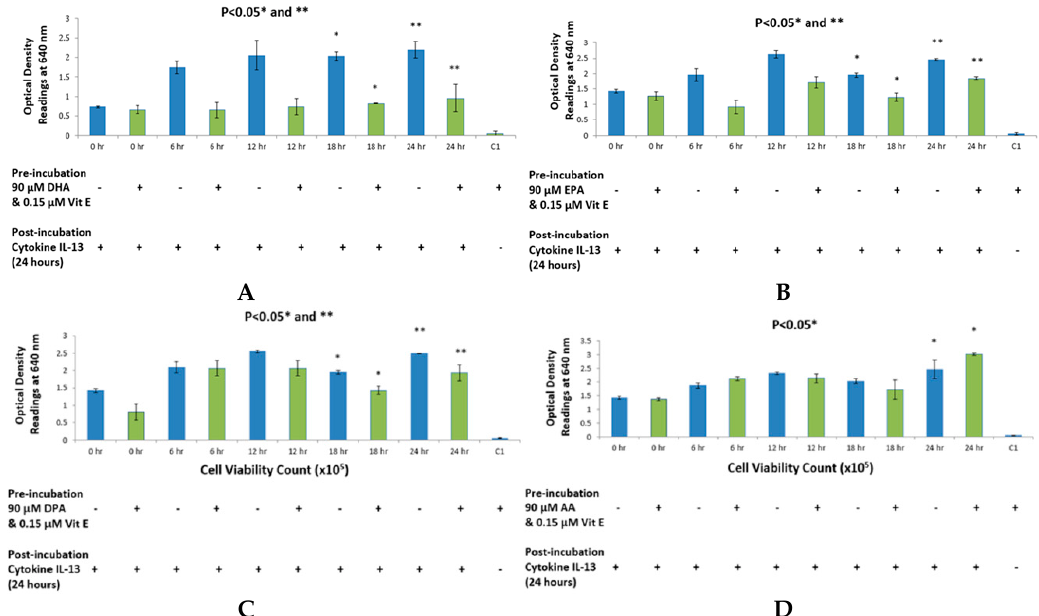
Figure 4. HEK-Blue detection assay with 90 μ M of omega-3 and omega-6 fatty acids with 0.15 μ M vitamin E using cytokine IL-13 as the bioactive agent. ( A – C ) depict a time-dependent inhibition of SEAP secretion from HEK-Blue cells when treated with DHA, EPA and DPA, respectively; Once again, ( D ) shows an increase in SEAP secretion from HEK-Blue cells when treated with AA at the 24-hour time point. * p < 0.05, ** p < 0.05 denotes significance of optical density readings compared to positive control depicted in blue colour. Control 1 (C1) depicts the optical density reading obtained when HEK-Blue cells are treated with fatty acid only, without cytokine stimulation.